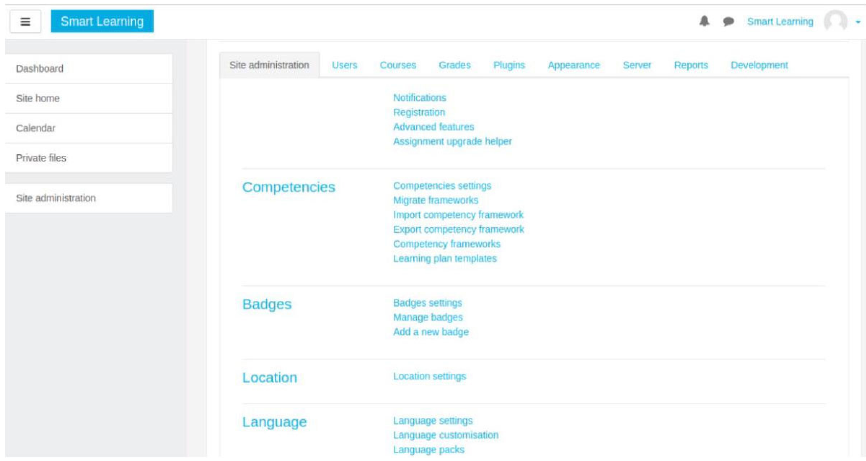
Fig. 2. System administrator interface